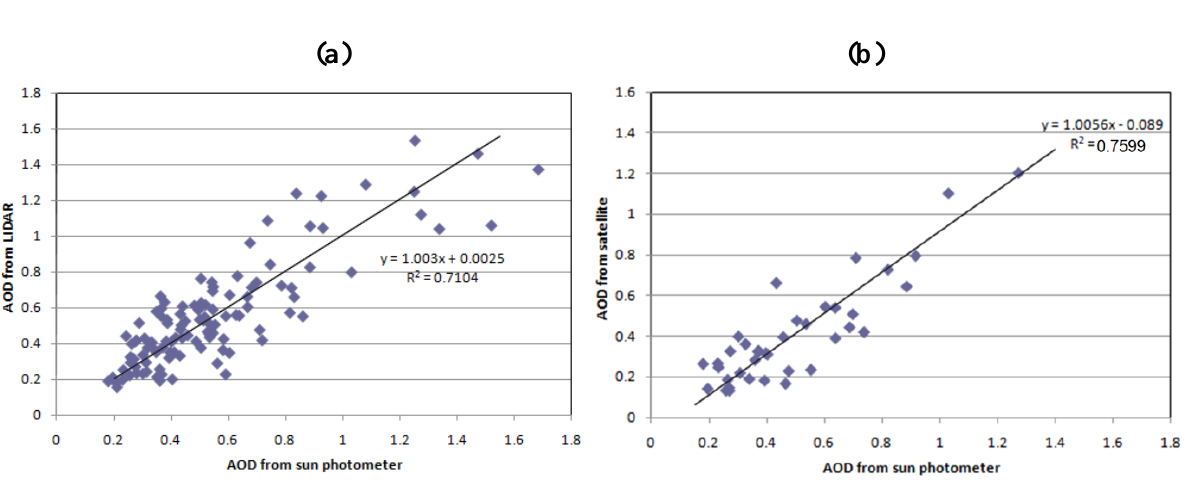
Figure 3. Scatter plot of AOD: (a) between LIDAR and sun photometer, and (b) between MODIS and sun